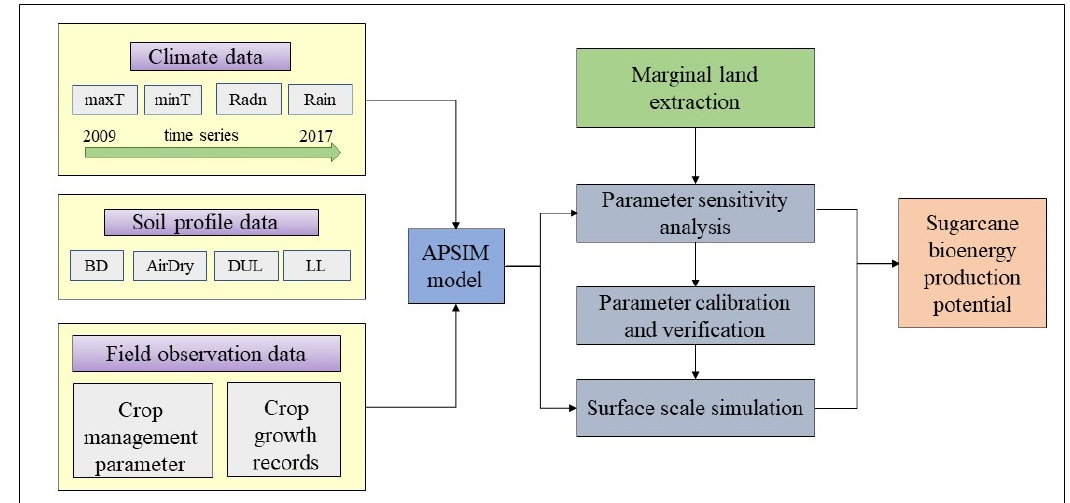
Figure 1. Analysis framework used in the current study for the potential production of bioenergy from sugarcane. The meanings of the abbreviations maxT, minT, Radn, and Rain refer to the maximum temperature, minimum temperature, solar radiation, and rainfall, respectively. The abbreviations BD, AirDry, DUL, and LL refer to the bulk density, air-dried soil moisture content, field capacity and wilting coefficient, respectively.